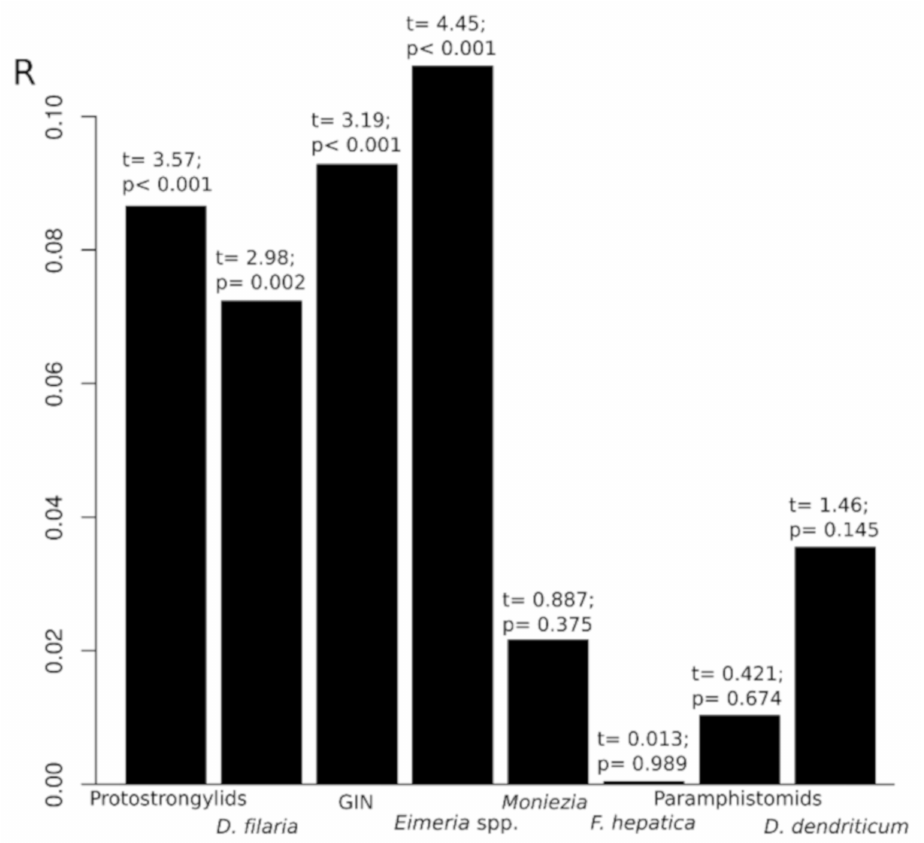
Figure 2. Partial least squares path modeling: correlation between mixed management and parasite infection in